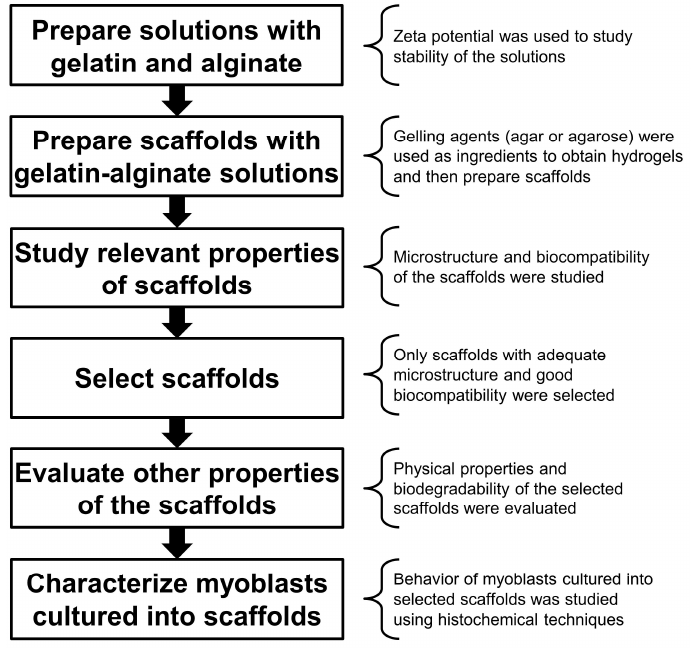
Figure 1. Experimental strategy.